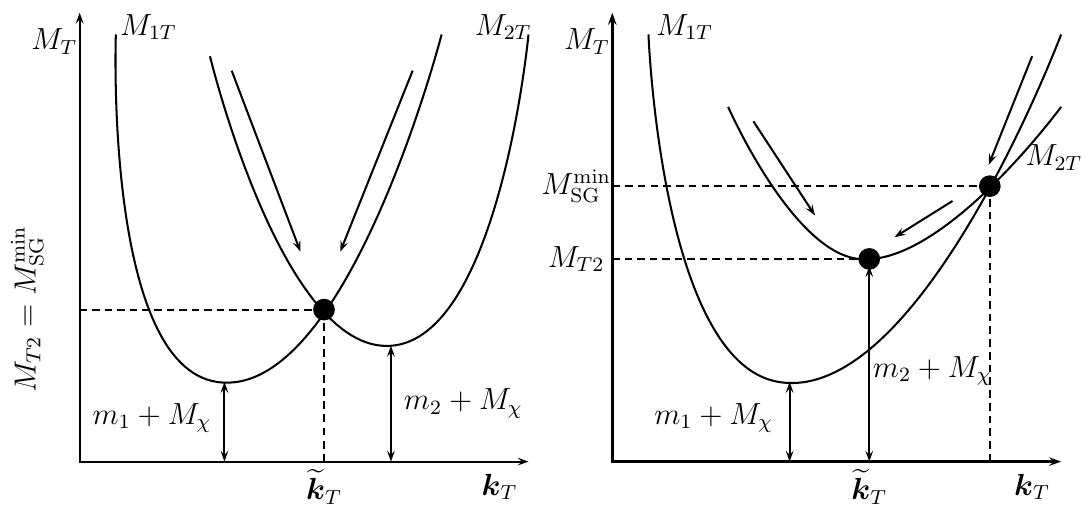
Figure 4 . The same pictures as in figure 1, but with depicting the minimum value of the singularity variable M min . The black dots in each plot correspond to either or both of the M T 2 and the M min SG values. e k T denotes the M T 2 solution to the invisible particle